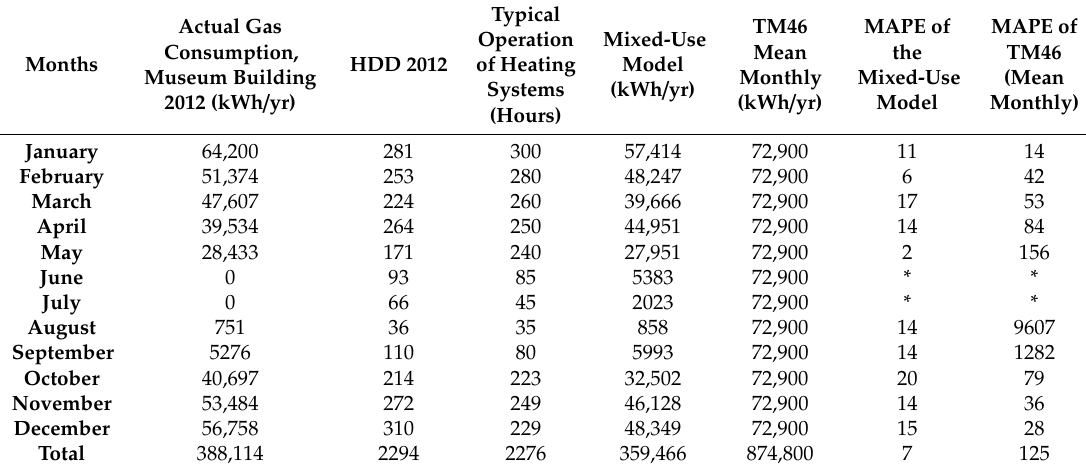
Table 5. Monthly heat demand and the percent of